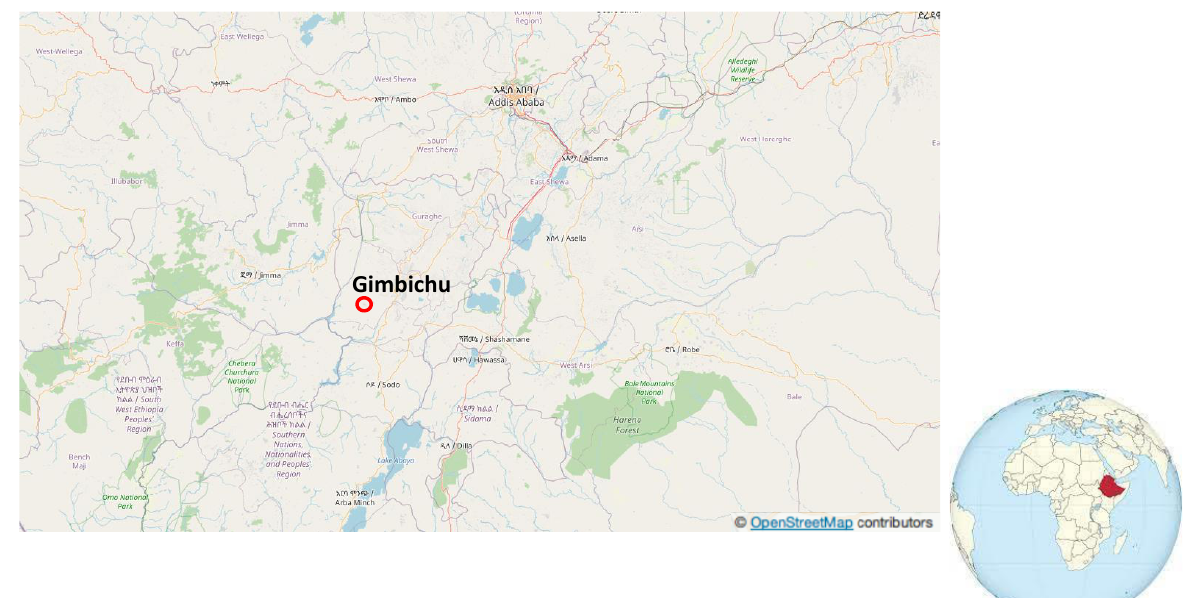
Figure 1. Localization of Gimbichu where this study was carried out using ©OpenStreetMap.